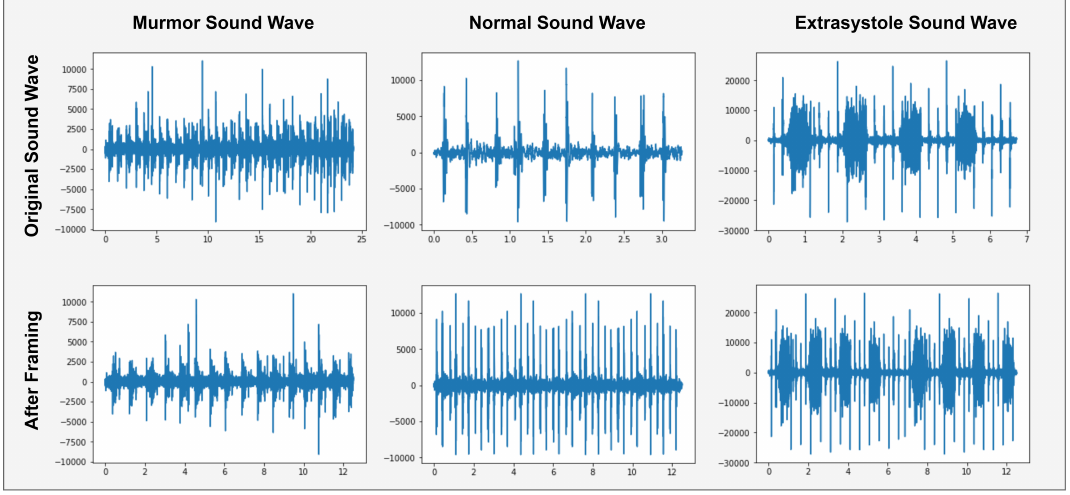
Figure 5. Graphical representation of Data Framing Heartbeat sound